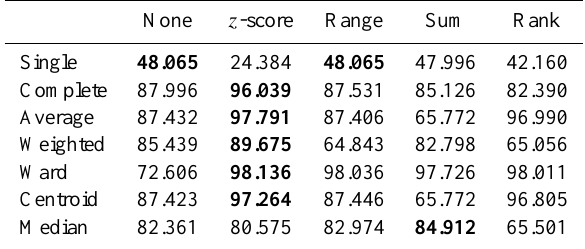
Table 2. Performance of the different linkages and normalisation procedures for the full data set in terms of the percentage of data points placed into the same cluster as the known clustering. In bold are the best-performing normalisations for each linkage.